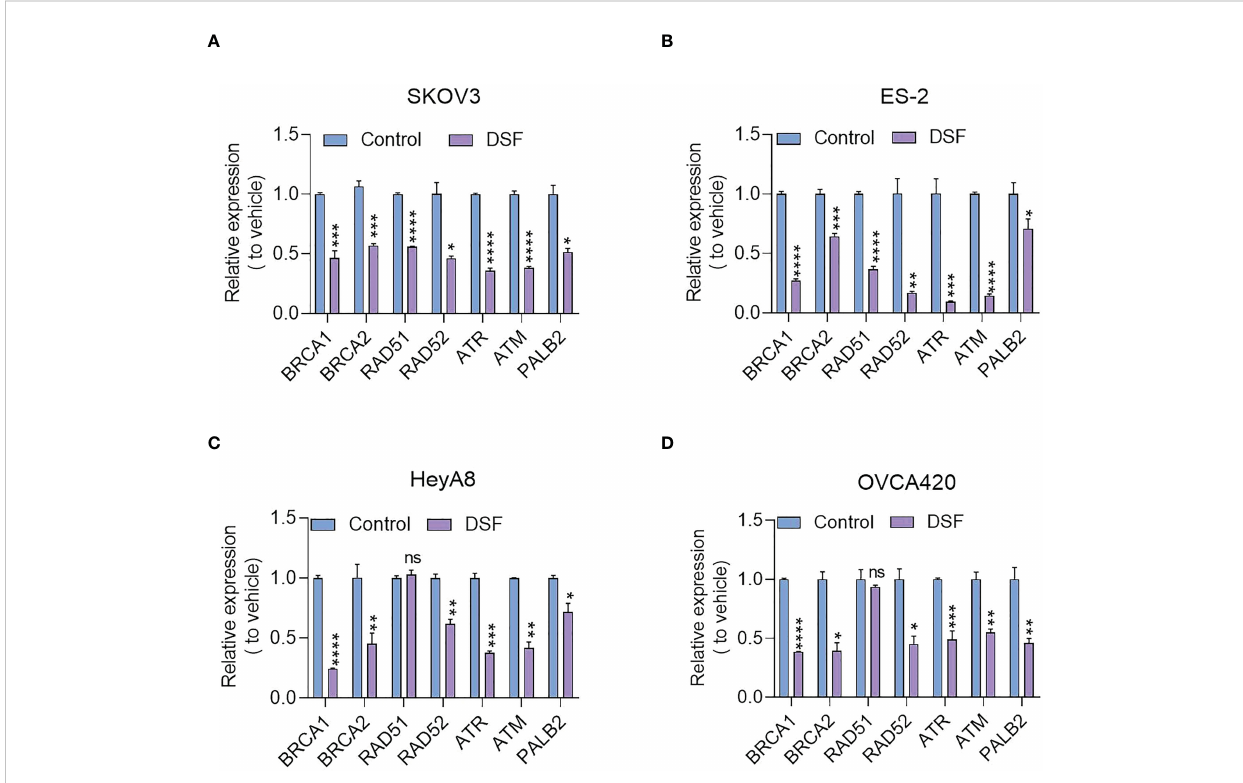
FIGURE 5 Effect of Disul fi ram on expression of HRR-related genes in SKOV3 (A) , ES-2 (B) HeyA8 (C) , and OVCA420 cells (D) . The fold-change of inhibition after Disul fi ram treatment was plotted in comparison to the control (blue). Each gene is denoted in the Figure. Experiments were repeated three times and represented as mean ± SD. Unpaired t-test, ns, no signi fi cant difference; * P <0.05, ** P <0.01, *** P <0.001, **** P